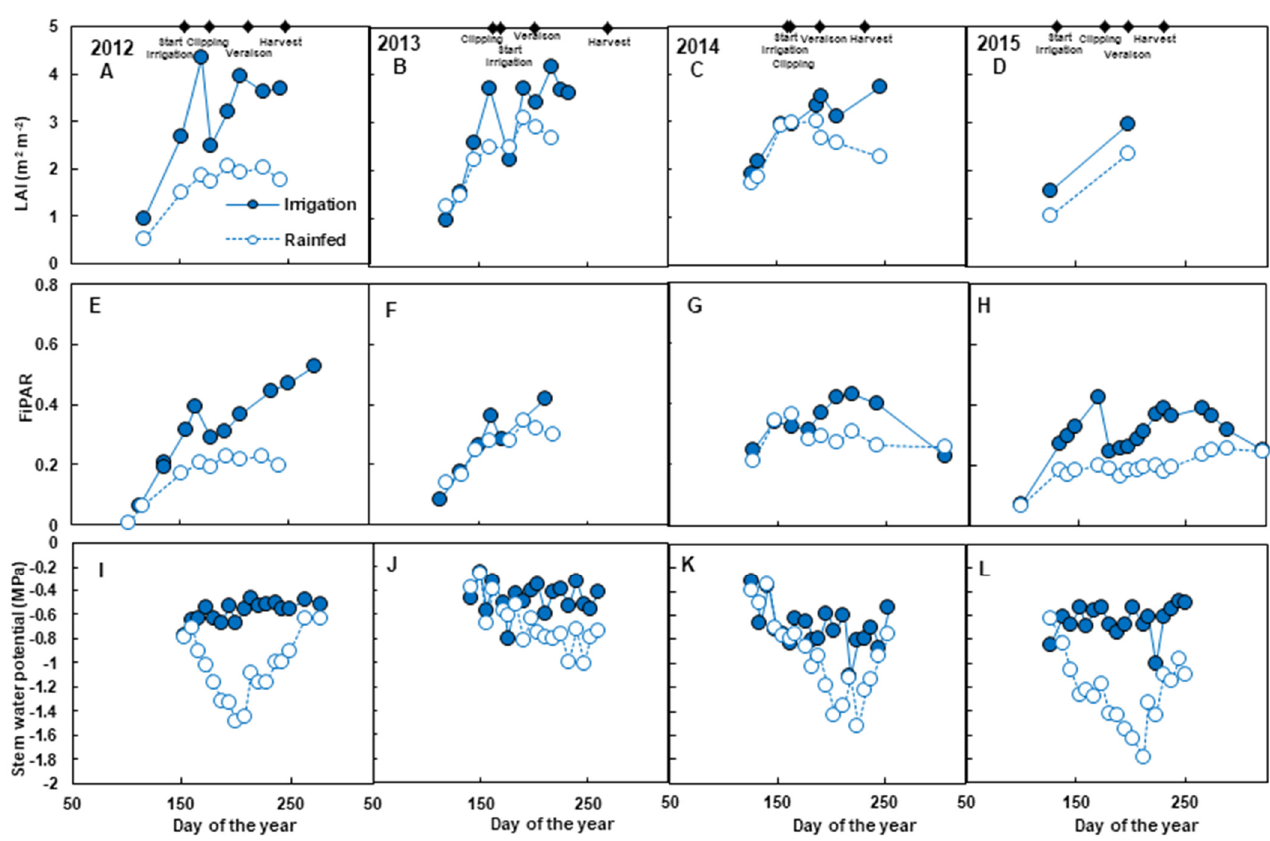
Figure 4. Seasonal evolution of leaf area index (LAI)—graphs ( A – D ). Fraction of intercepted photosynthetically active radiation (FiPAR)—graphs ( E – H ). Stem water potential at midday ( Ψ smd ) in MPa—graphs ( I – L ) of the treatments considered (Irrigated and Rainfed), in 2012, 2013, 2014 and 2015.